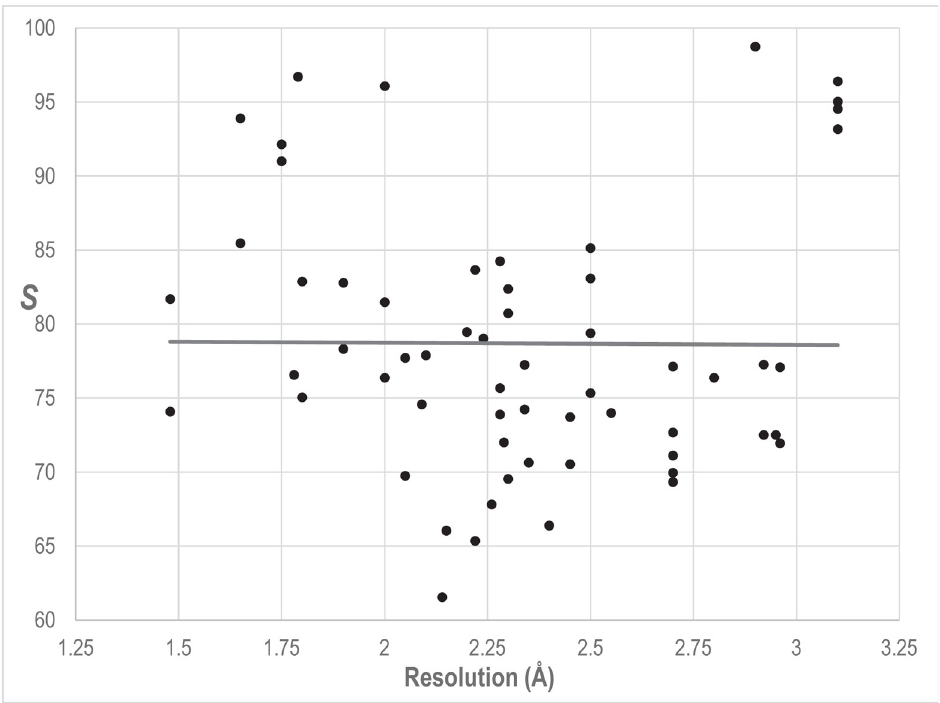
Fig 4. Regression analysis of S for 60 Ran GTPase structures versus their crystal structure resolutions. The coefficient of determination is R 2 = 0.00005, indicating that crystal structure resolution fails to explain the variability of S around its mean. The same R 4 family MSA and parameters were used here as for the analyses in Table 4.